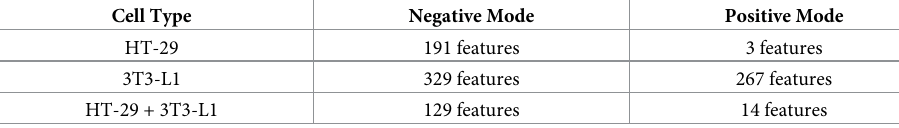
Table 1. Molecular features of 3D cultured